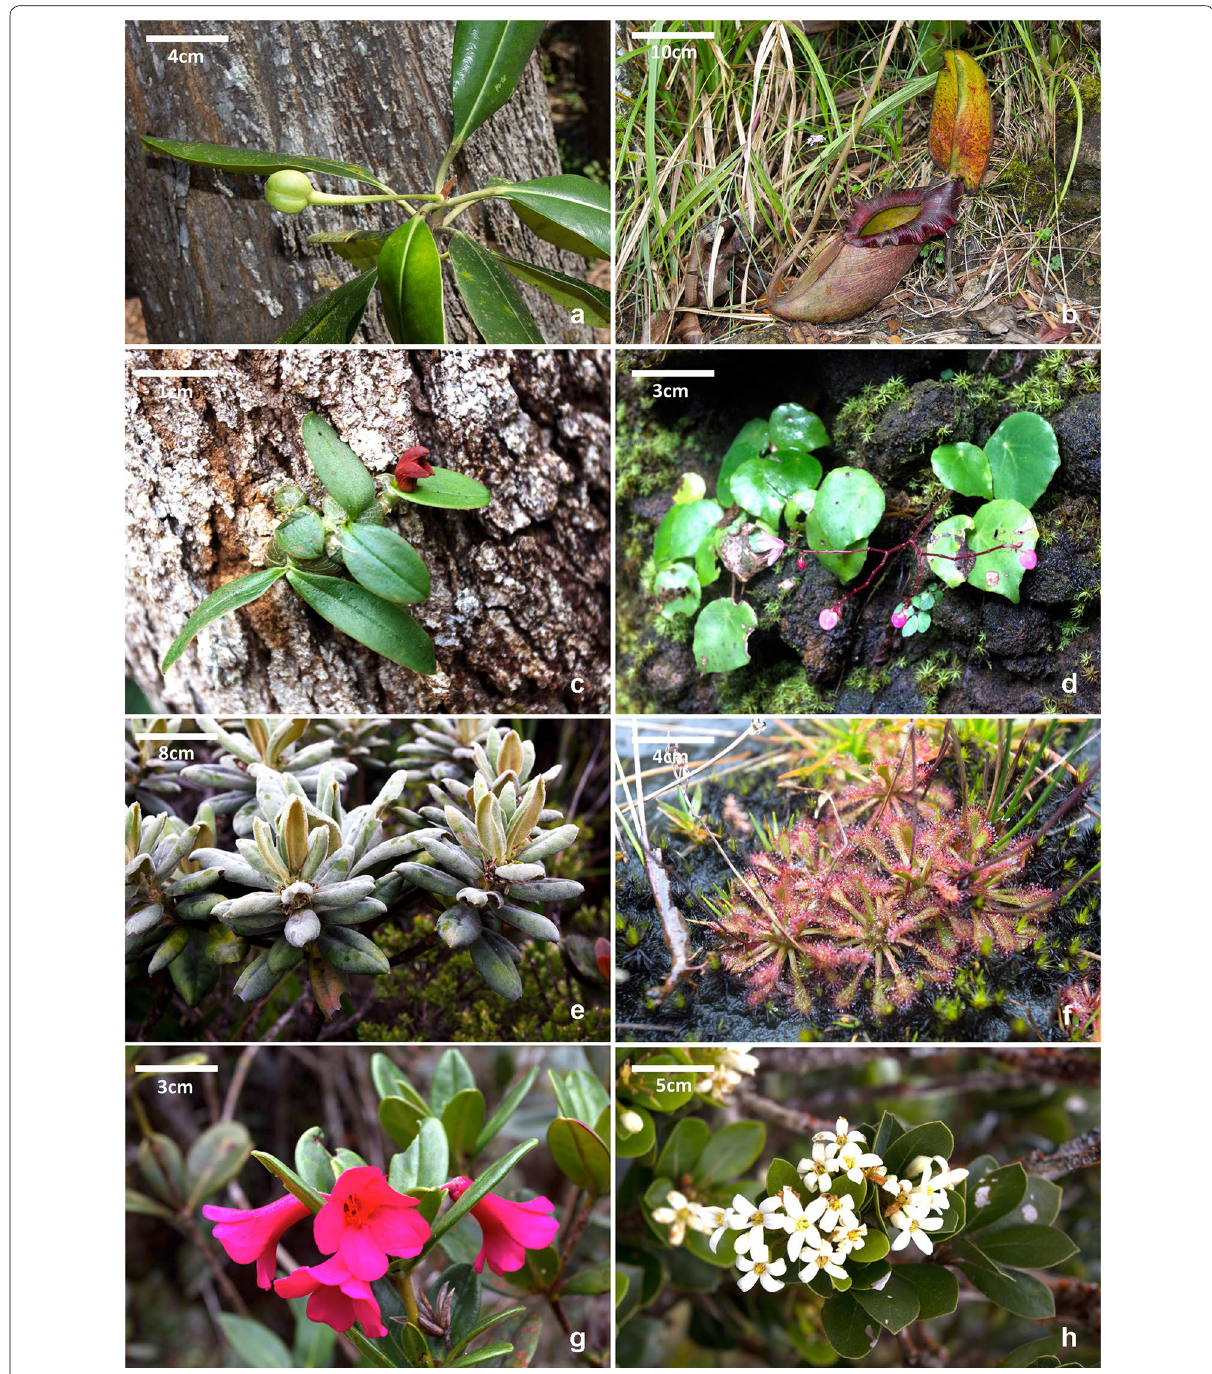
Fig. 4 Ultramafic edaphic endemics from South and Southeast Asia: a The monotypic tree Borneodendron aenigmaticum (Euphorbiaceae) is endemic to Sabah (Malaysia) on ultramafic soils in the lowlands. b The world’s largest carnivorous pitcher plant, Nepenthes rajah (Nepenthaceae) is endemic to Kinabalu Park in Sabah where it occurs in the montane zone. c The epiphytic or lithophytic orchid Porpax borneensis (Orchidaceae) is restricted to ultramafic outcrops in Sabah, Malaysia. d The recently described Begonia moneta (Begoniaceae) occurs lithophytically in lowland ultramafic forest in Sabah, Malaysia. e Scaevola verticillata (Goodeniaceae) is endemic to the summit of the ultramafic Mount Tambukon in Sabah, Malaysia. f The carnivorous Drosera ultramafica (Droseraceae) is endemic to a limited number of mountainous ultramafic outcrops in Malaysia and the Philippines. g Rhododendron baconii (Ericaceae) is another hyper-endemic restricted to Kinabalu Park, Sabah, Malaysia. h The specific epithet of Pittosporum peridoticola (Pittosporaceae) indicates its habitat is on ultramafic soils in Sabah, Malaysia (all images are by A. van der